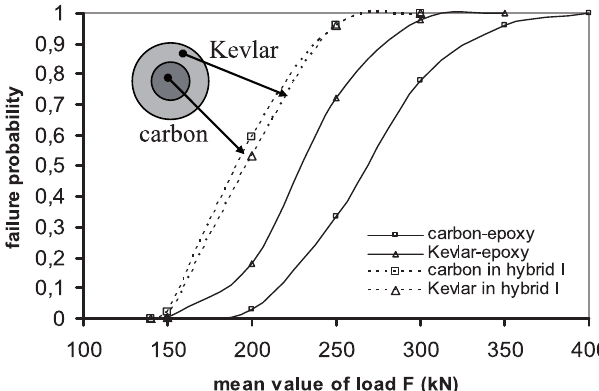
Fig. 13. Failure probability of hybrid I according to axial load F ( q = 0 . 5